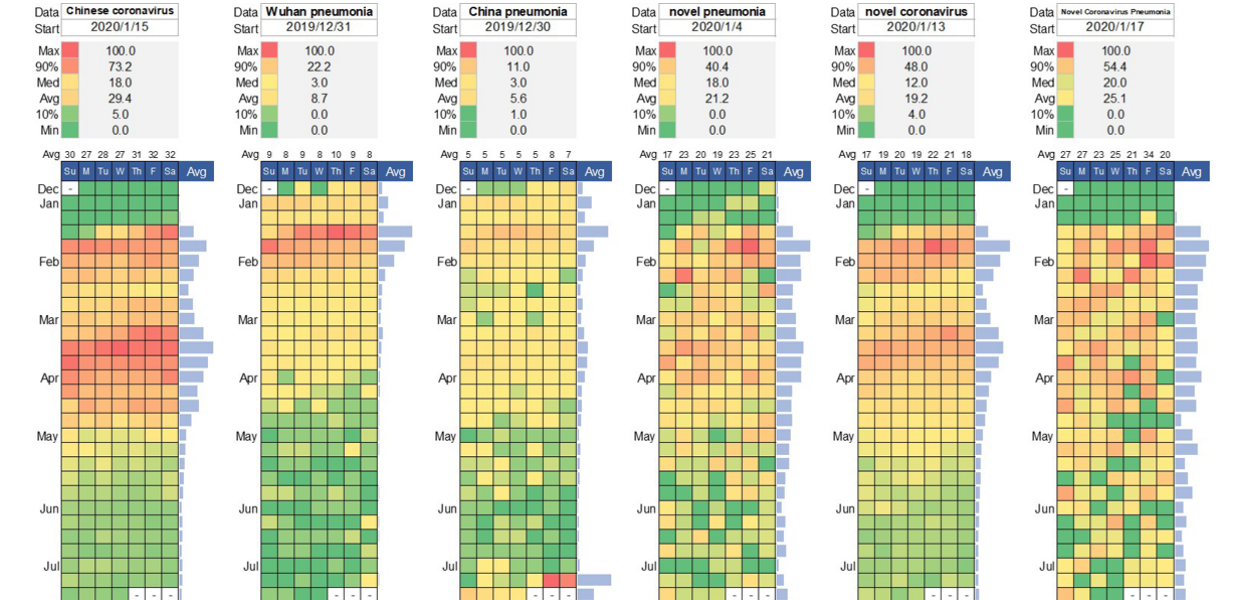
Figure 2. Calendar illustration on the relative search interest of the COVID-19 infodemic in the context of the COVID-19 epidemic (as of July 15, 2020; part